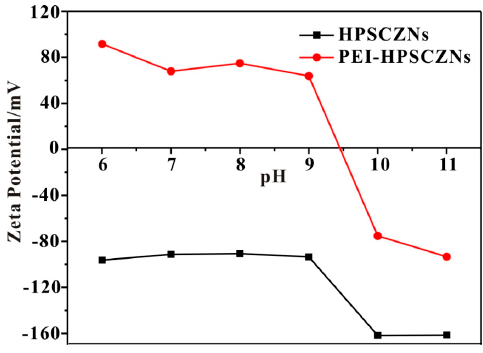
Figure 6. Relationship between Zeta potential of HPSCZNs and PEI-HPSCZN with different pH value. When mixing HPSCZNs with PEI aqueous solution, electrostatic interactions enable PEI loading on the surface of HPSCZNs. In this condition, surface charges of the HPSCZNs are adjusted to positive. The Au NPs are negative charged due to the citric acid on its surface.